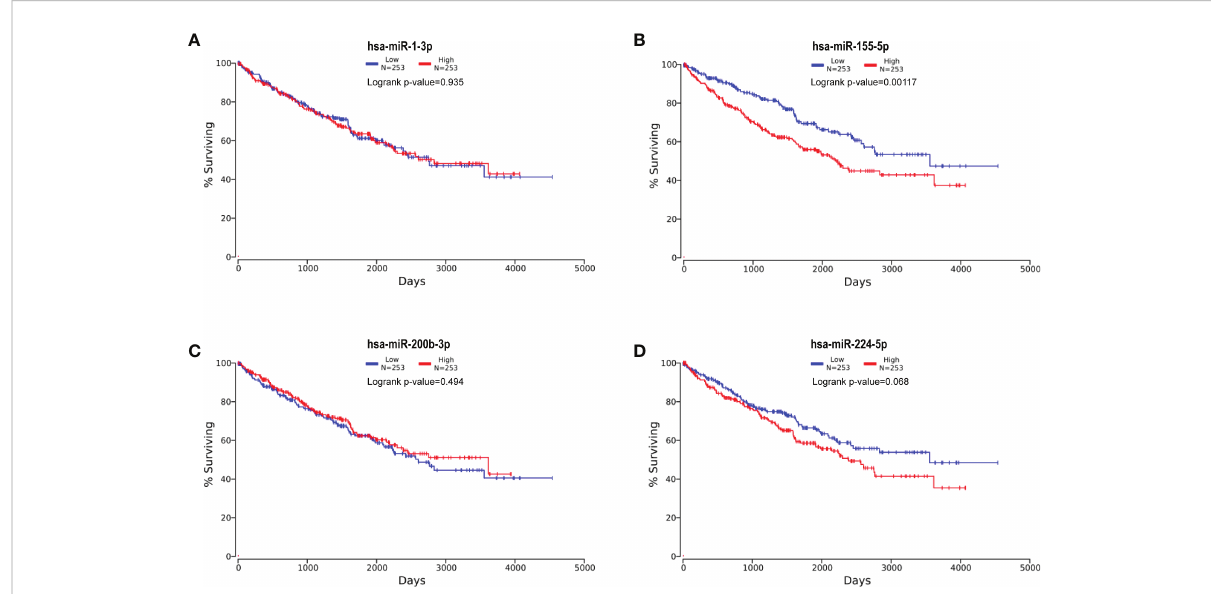
FIGURE 7 Kaplan – Meier survival curves of four candidate miRNAs. Kaplan – Meier survival curves of hsa-miR-1-3p (A) , hsa-miR-155-5p (B) , hsa-miR-200b- 3p (C) , and hsa-miR-224-5p (D) . The analysis manifested that miR-155-5p signi fi cantly associated with RCC survival rate, and RCCs with higher miR-155-5p expression level tended to have worse